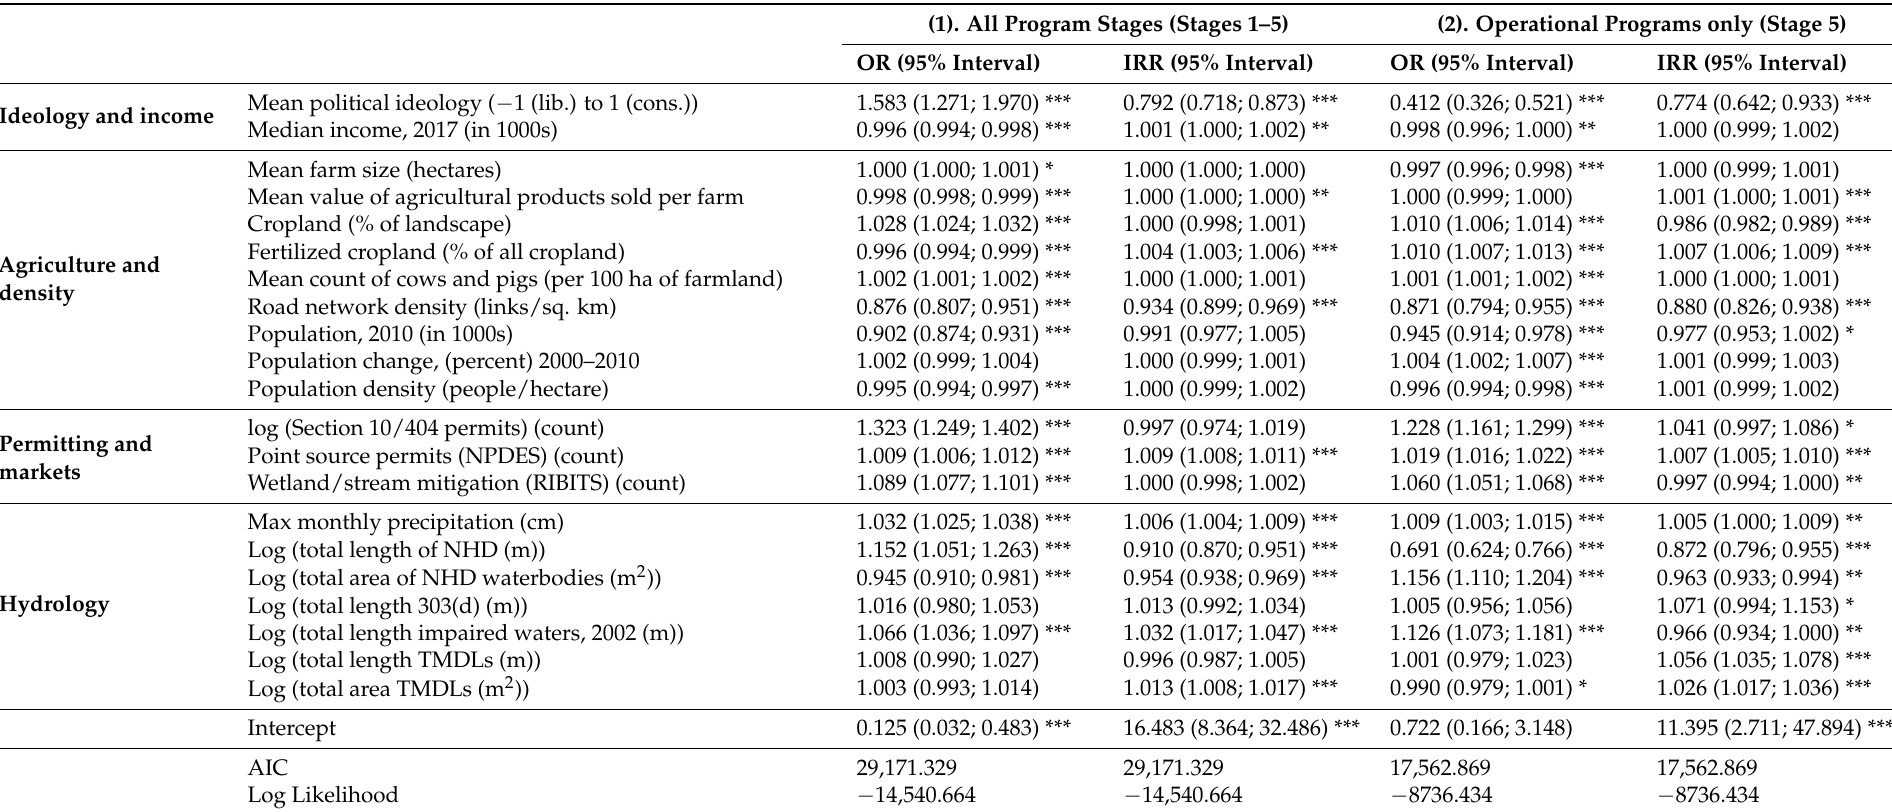
Table 3. Hurdle model predictions of existence and abundance of (1) operational and nonoperational water quality trading programs (all Stages 1–5) and (2) operational water quality trading programs (Stage 5 only). Depicts effects on odds ratios (OR) for binary logistic regressions and incident rate ratios (IRR) for truncated negative binomial regressions, with 95% confidence intervals for each ( n = 6940 tracts for all). * p < 0.1; ** p < 0.05; *** p <